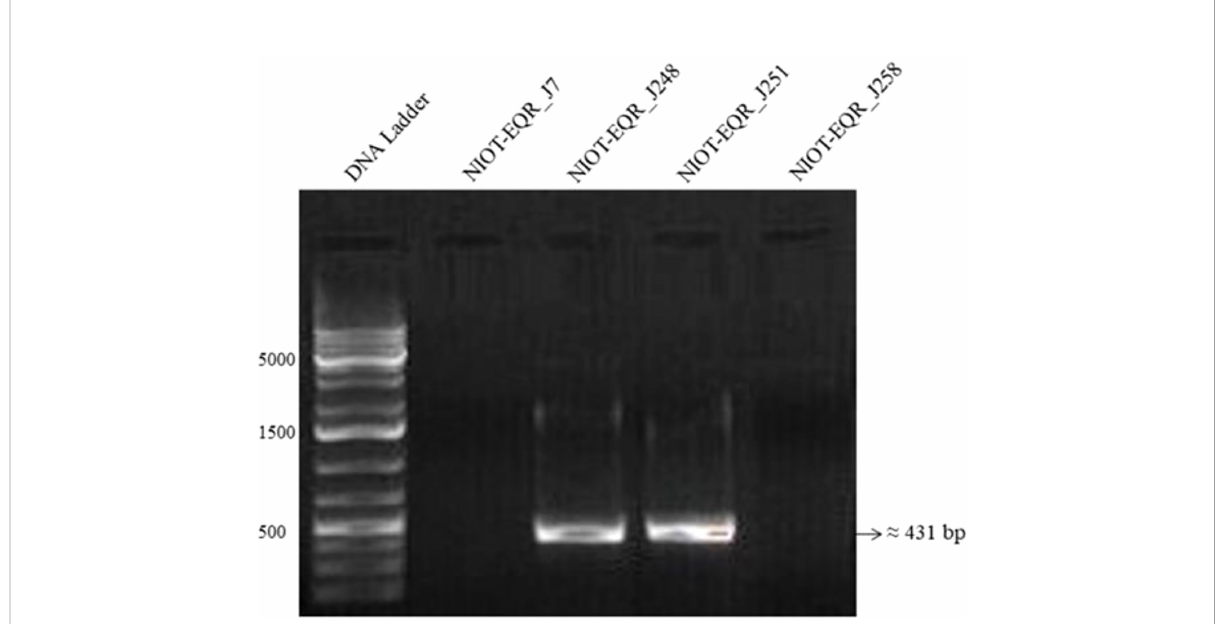
FIGURE 3 Gel electrophoresis of merA gene amplicons of MRB and MMRB strains using F1 merA and F2 merA primer set. Lane 1: Gene Ruler 1 kb Plus DNA Ladder, Lane 2 and 5: Negative PCR reaction, and Lane 3 and 4: ampli fi ed